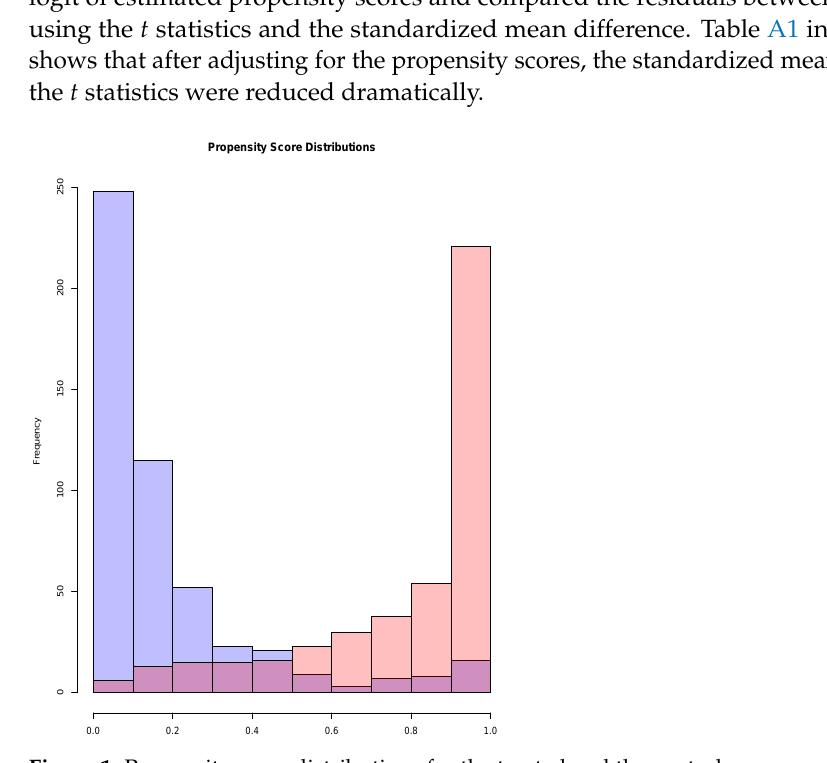
Figure 1. Propensity score distributions for the treated and the